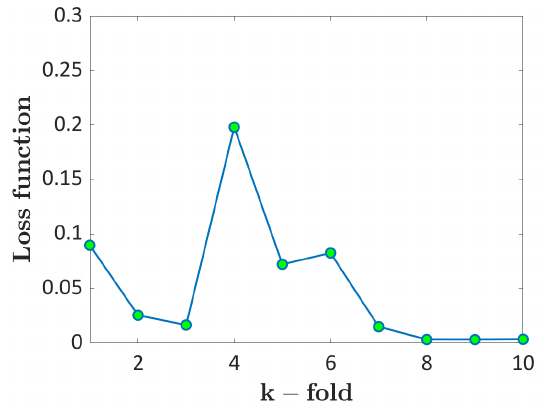
Figure 9. k-fold cross-validation for the LEVD ML: loss function with respect to the k-fold consid- ered for the validation. for the